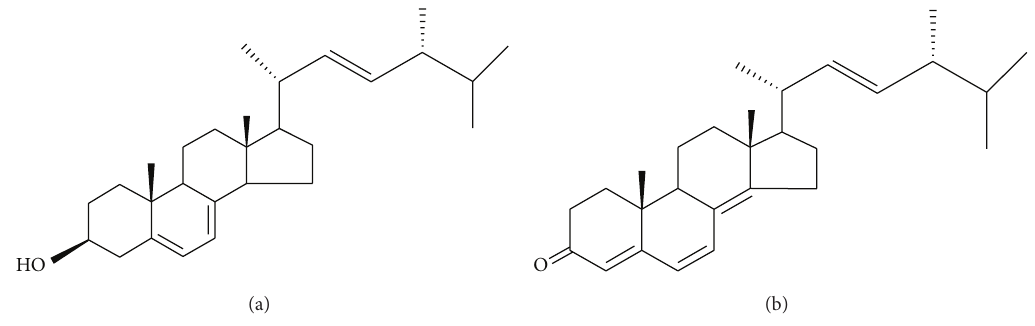
Figure 1: Chemical structures of ergosterol (a) and ergone